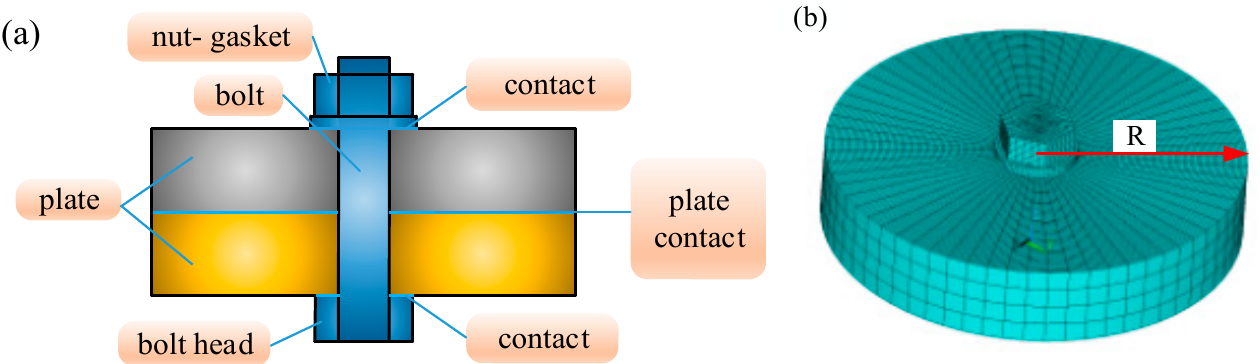
Figure 1. Contact analysis: ( a ) contact structure, and ( b ) elemental mesh. The results of contact analysis can be seen in Figure 2a. As can be seen from the ana- lytical results, the influence of bolted joints on structure exhibits strong local characteristics. To obtain the distribution of the contact pressure between the plates, the values of contact pressure along the R-axis are extracted and drawn in Figure